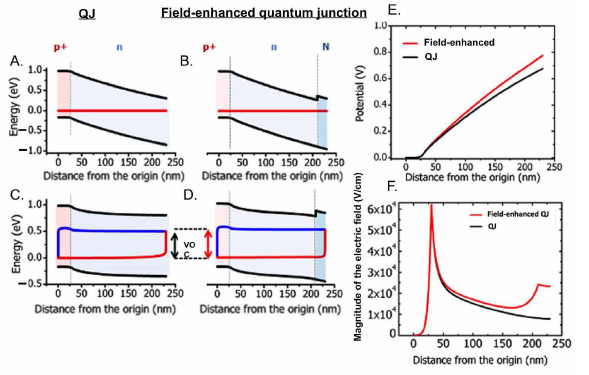
Fig. 4. (A, B) Simulated equilibrium band diagrams of QJ and field- enhanced QJ structures, respectively. (C, D) Simulated band dia- grams at open-circuit conditions for the same structures as in (A) and (B), respectively, under 1000 W/m 2 solar illumination. The field- enhanced QJ design exhibits a higher open-circuit voltage due to the increased separation between the Fermi levels of the p- and n-type layers and (E) a higher built-in voltage at equilibrium. (F) Simulated electric field inside the solar cell active layers at the max- imum power point. The field-enhanced QJ architecture exhibits a higher electric field magnitude. The electric field vector is directed toward the p-layer, driving minority holes toward their selective contact during photovoltaic operation. Reprinted with permission from [231]. Copyright 2013 AIP Publishing LLC.